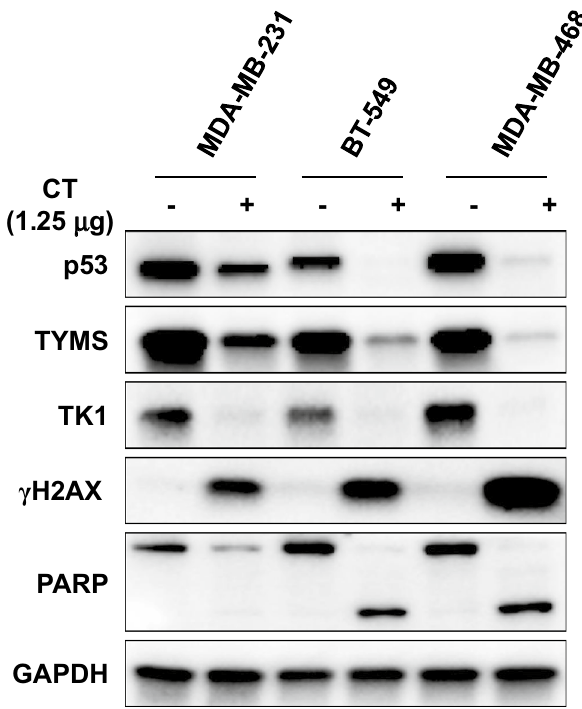
Figure 9. Western blot analysis of CT transfected TNBC at 12 h. All TNBC cells used in this study have mutant p53 as follows; p53(R280K) in MDA-MB-231, p53(R249S) in BT549, and p53(R273H) in MDA-MB-468 76 . The band for p53 in MDA-MB-231 represents the mutant p53 as the smaller protein and the other bands for BT549 and MDA-MB-468 as the larger protein. Original blots are presented in Supplementary Information (Figure Raw